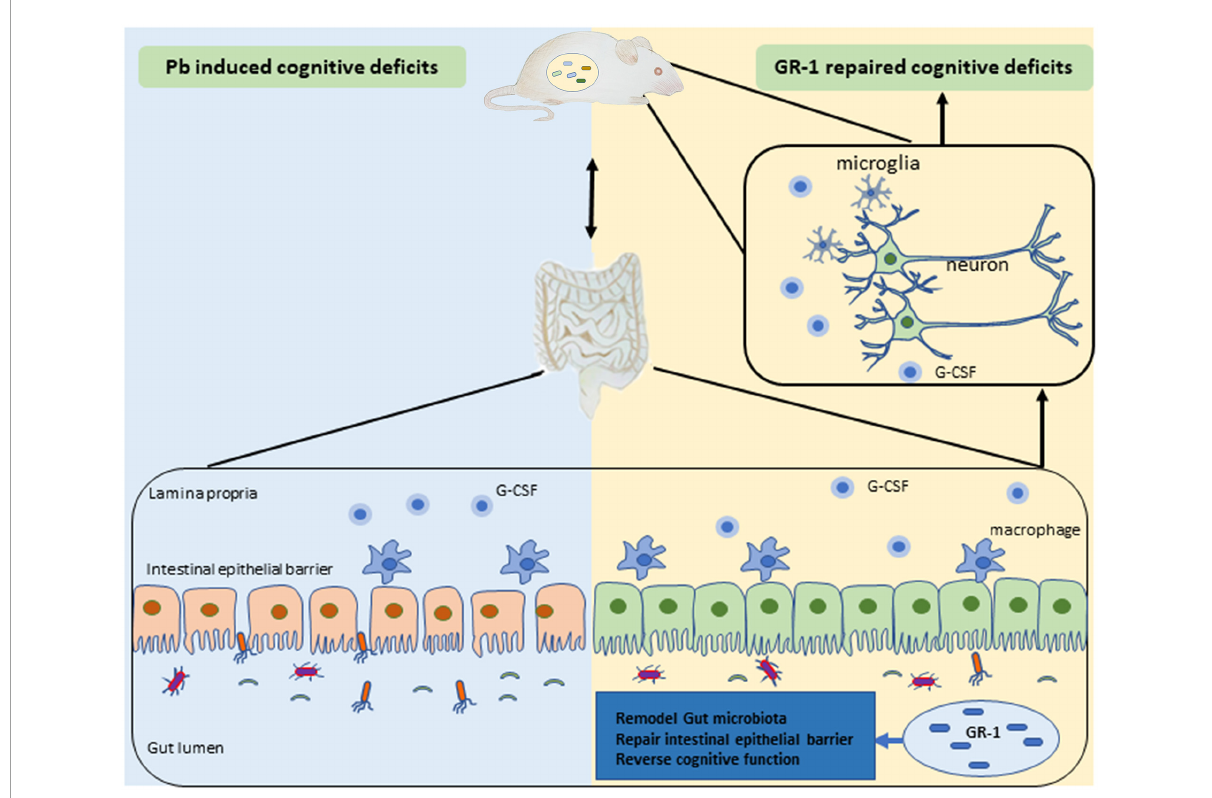
FIGURE8 Schematic diagram of Lactobacillus rhamnosus GR-1 attenuated the Pb-induced learning and memory